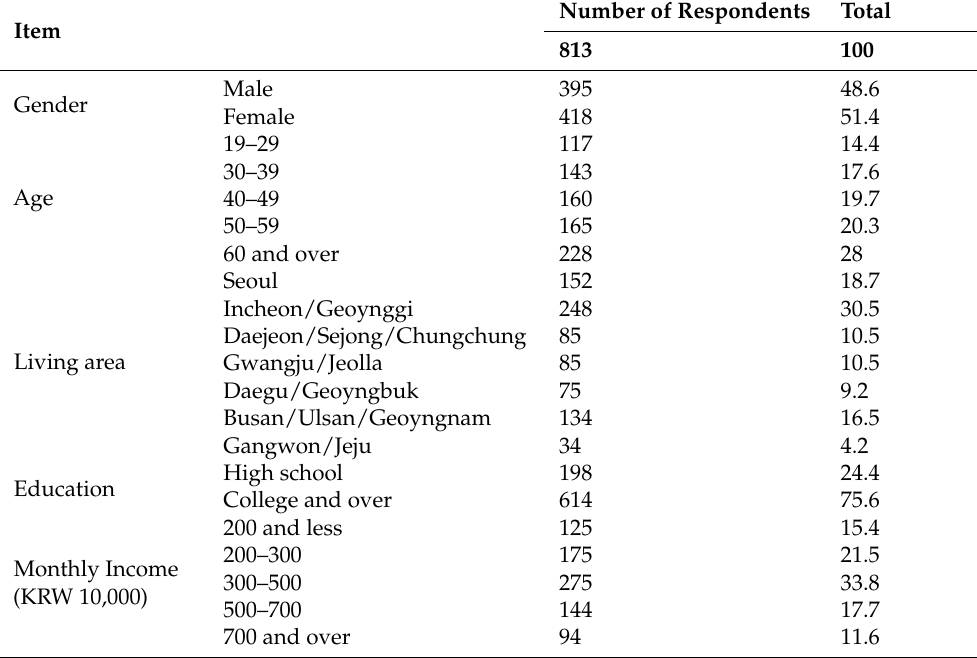
Table 1. Distribution of Respondents by Socio-Demographic Variables.